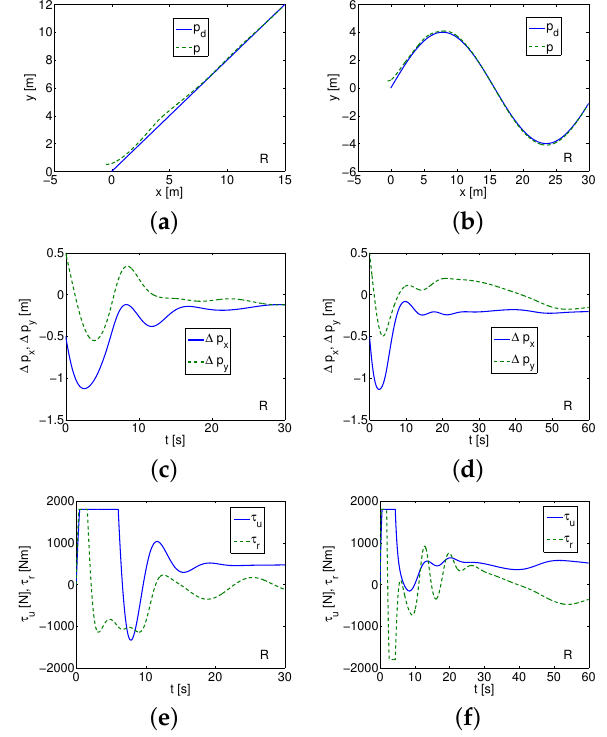
Figure 5. Simulation results for ROPOS (SMC/backstepping)—linear and sine trajectory. ( a , b ) Desired and realized trajectory; ( c , d ) position errors; ( e , f ) applied